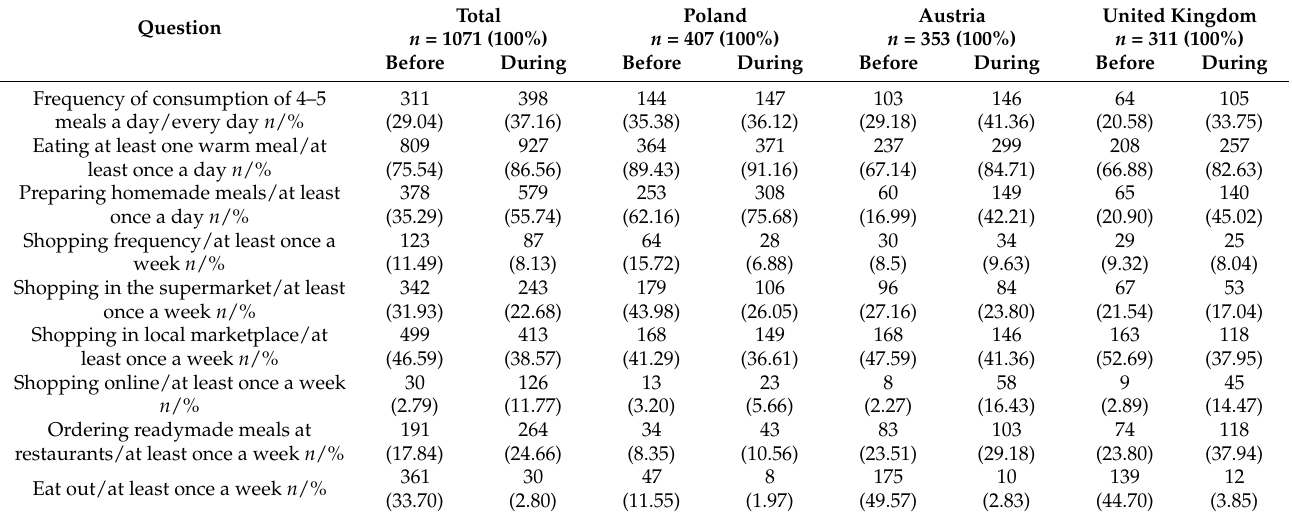
Table 2. The frequency and place of the shopping of selected products before and during